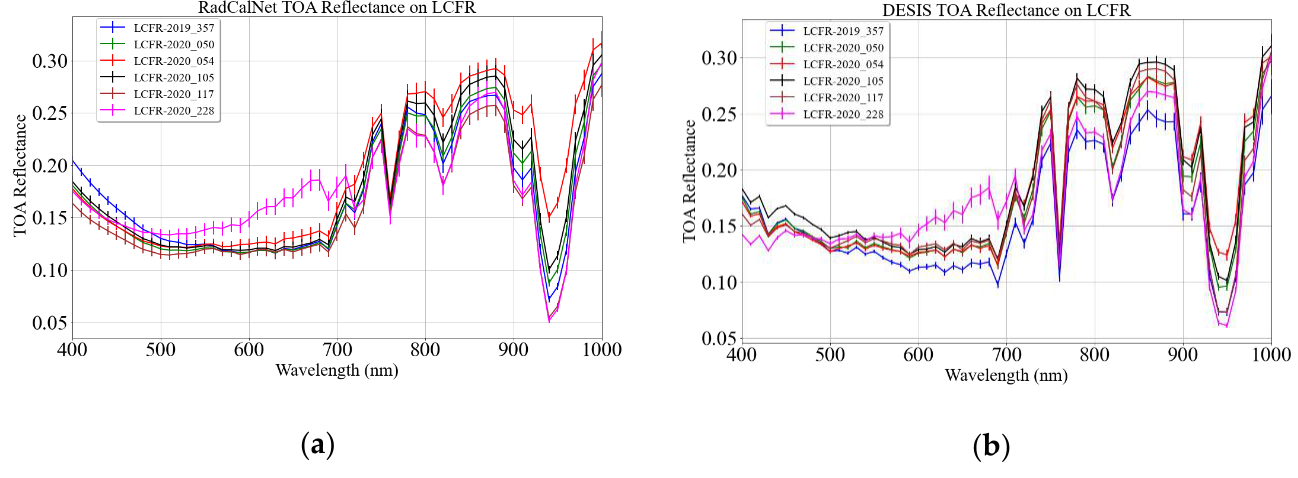
Figure 14. LCFR TOA reflectance, RadCalNet ( a ) and DESIS ( b ). Figure 15a shows the DESIS normalized TOA reflectance on LCFR. The normalized reflectance is more variable than observed in the previous two sites: RVUS and GONA.